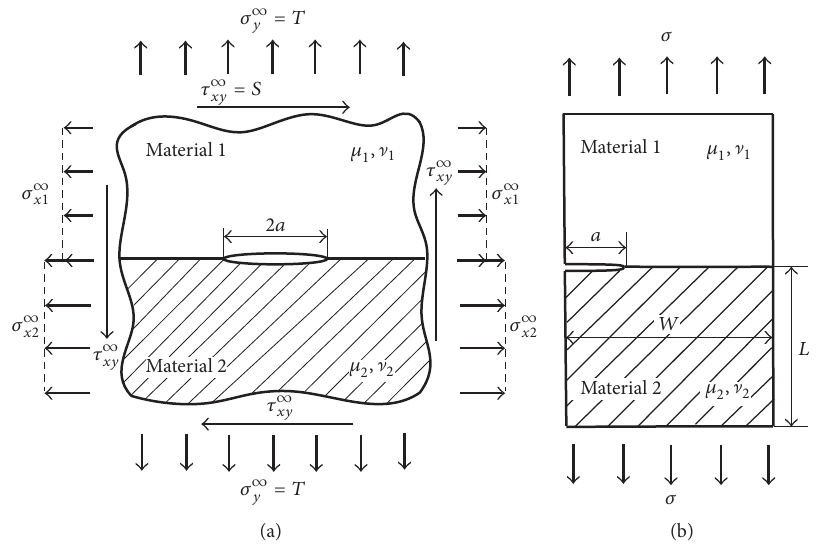
Figure 2: Geometric configuration for (a) the reference Problem 𝐴 and (b) the given unknown Problem 𝐵 .